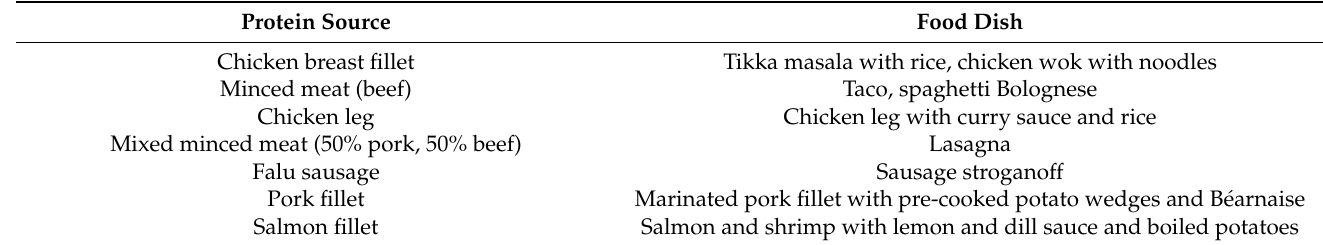
Table 3. The 10 food dishes based on consumer purchase associations from ACIT * for each protein. Protein Source Food Dish Chicken breast fillet Tikka masala with rice, chicken wok with noodles Minced meat (beef) Taco, spaghetti Bolognese Chicken leg Chicken leg with curry sauce and rice Mixed minced meat (50% pork, 50% beef) Lasagna Falu sausage Pork fillet Marinated pork fillet with pre-cooked potato wedges and B é arnaise Salmon